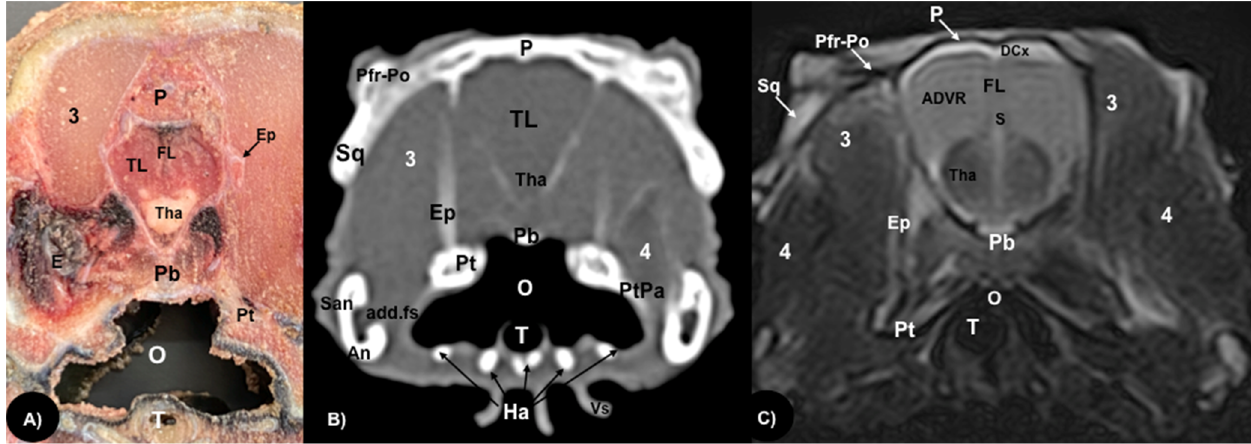
Figure 5. Transversal gross ‐ section ( A ), CT bone window ( B ) and MRI in T2W ( C ), images of the head of rhinoceros iguana at the level of the anterior dorsal ventricular ridge (ADVR) corresponding to line IV in Figure 1. P: Parietal bone. Pfr ‐ Po: Postfrontal ‐ Postorbital bone. Sq: Squamousal bone. E: Eyeball. TL: Telencephalon. FL: Fissura longitudinalis cerebri. Tha: Thalamus. ADVR: Anterior Dorsal Ventricular Ridge. DCx: Dorsal cortex. 3: Musculus adductor mandibulae externus medialis . 4: Musculus adductor mandibulae externus superficialis . Pb: Parabasisphenoid bone. Pt: Pterygoid bone. Ep: Epipterygoid bone. PtPa: Pterygoid ‐ palatine processes. add.fs: Adductor fossa. An: Angular bone.